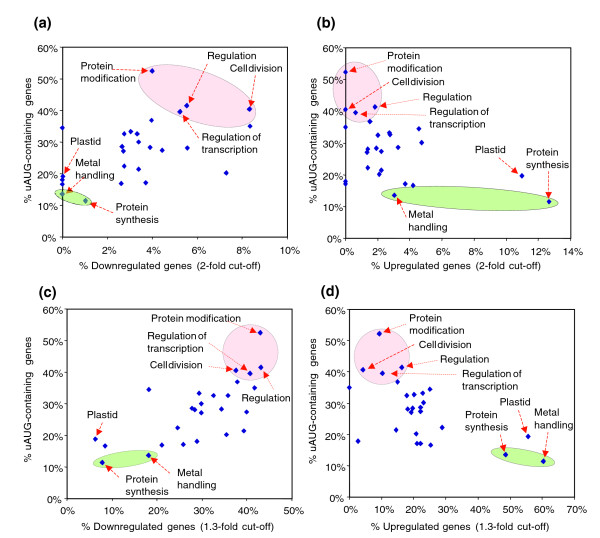
uORF content and eIF3h-dependent polysome loading are correlated across functional categories of genes. Each datapoint represents a functional class of genes. The percentages of translationally up- or downregulated genes were plotted against the percentages of uAUG-containing genes in a given functional class. The four classes with the highest occurrence of uORFs and the two classes with the lowest occurrence are highlighted with pink and green circles, respectively. The left panels (a, c) focus on genes whose polysome loading is reduced in the eif3h mutant; whereas the right panels (b, d) focus on genes with stimulation of polysome loading. (a, b) Stringent cutoff; only genes with a two-fold or higher difference in polysome loading were considered. (c, d) Relaxed cutoff; genes with a 1.3-fold or higher difference in polysome loading were considered. Note that the correlation is apparent in each case.